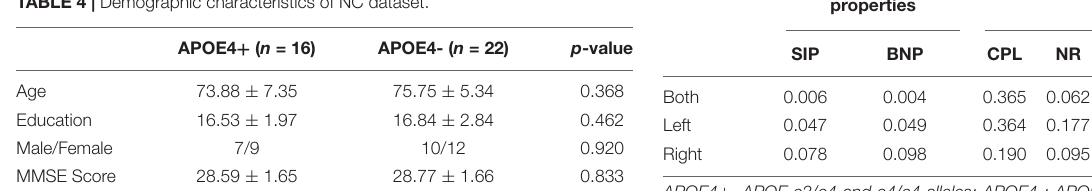
TABLE 5 | Statistical p -values of different network properties on NC between APOE4 + and APOE4- groups.